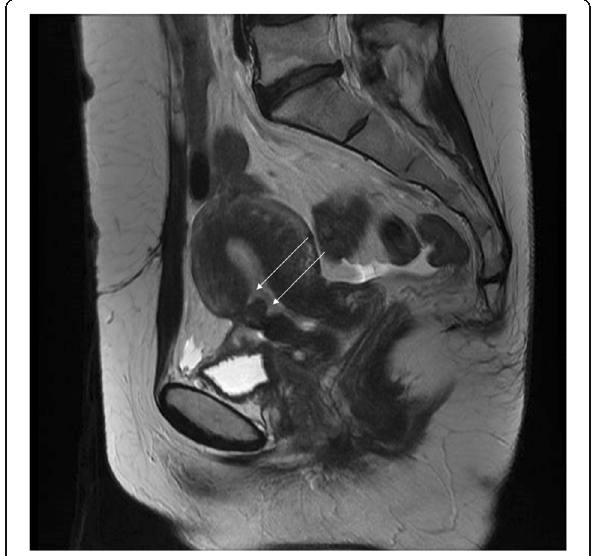
Fig. 5 Pelvic MRI, FSE/T2WI in sagittal plane: two hyperintense niches after two C-sections (arrows)